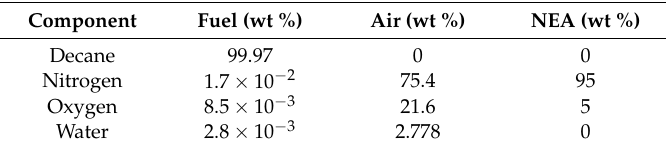
Table 1. Mass fraction of the components of the fuel, air and NEA.